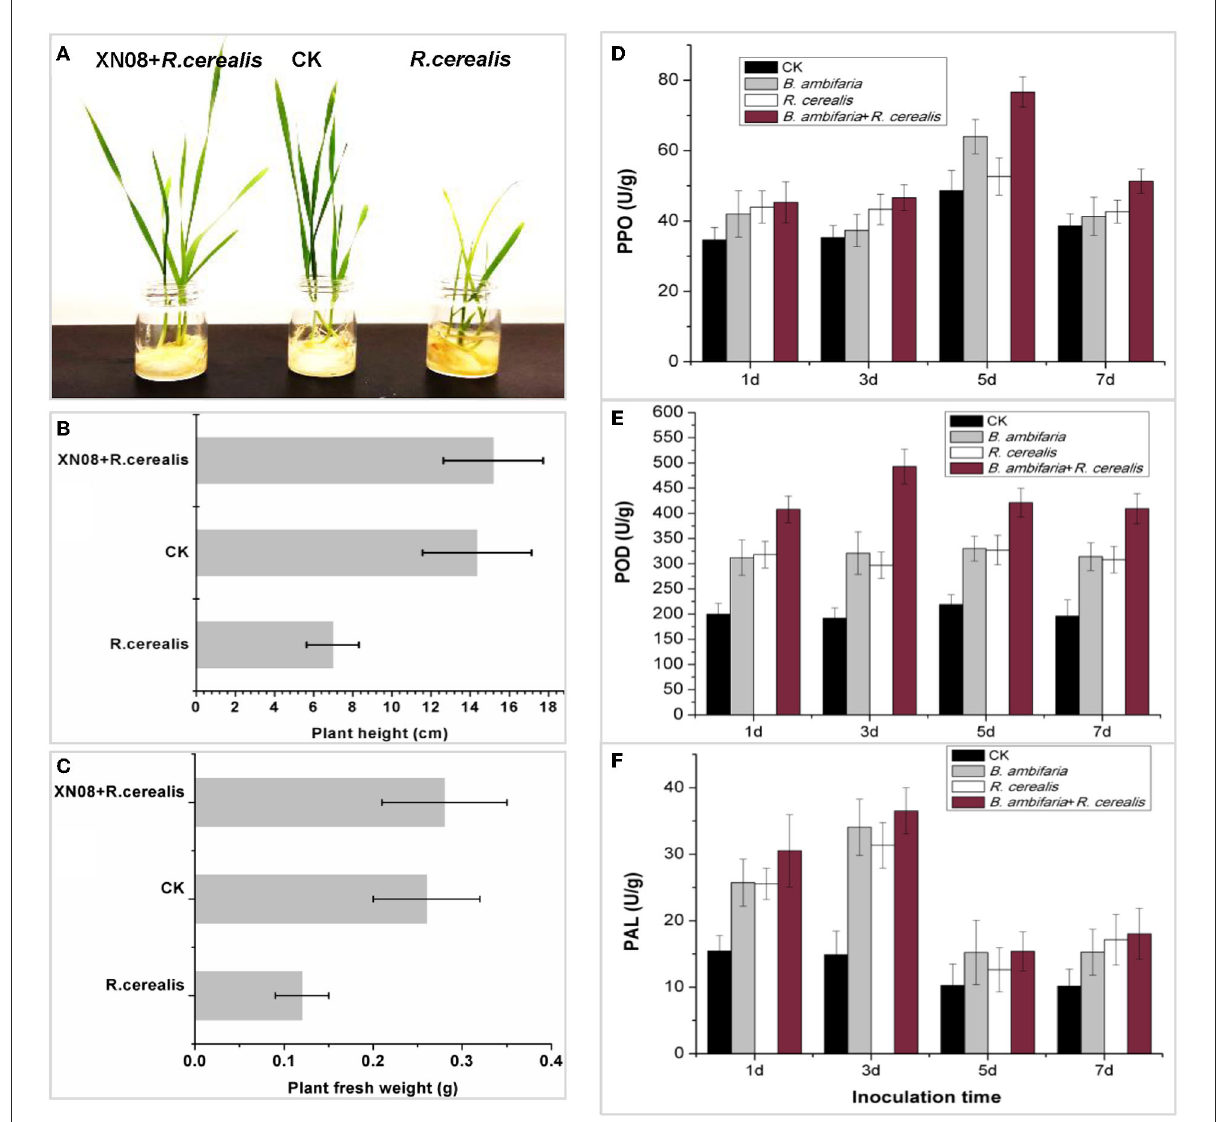
FIGURE4 Antagonistic activities and plant growth-promoting characteristics of the strain XN08 in the pot experiments. Morphological changes in wheat seedlings (A) , plant heights (B) , plant fresh weights (C) , and the activities of defense enzymes, including PPO (D) , POD (E) , and PAL (F) under different